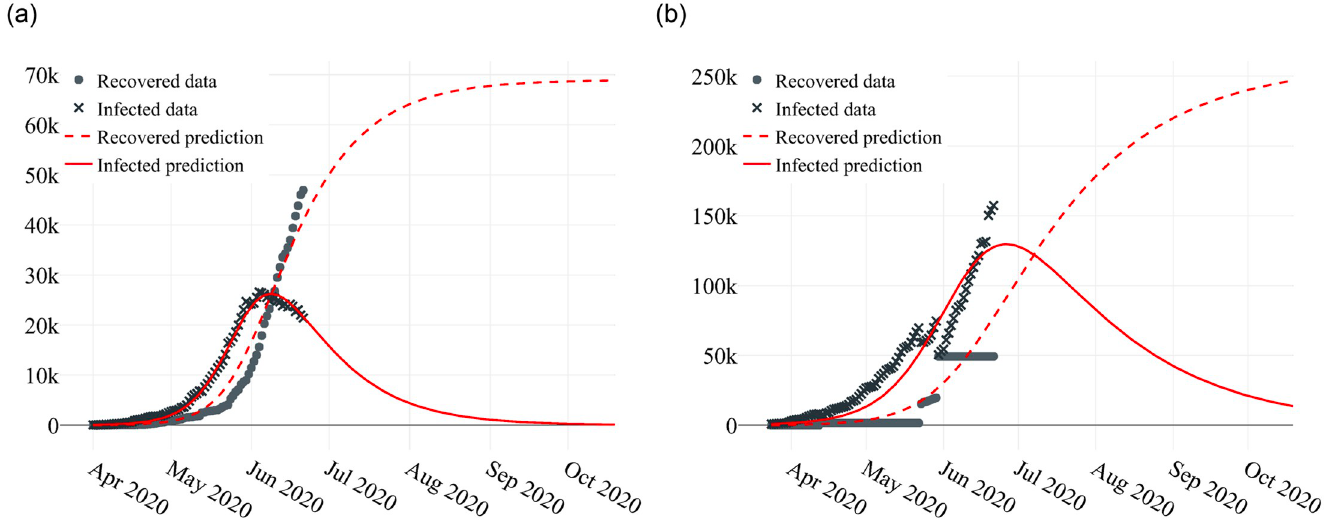
Fig 1. Comparison of predictions using the estimated models, with each state real data. (a) Maranh ã o results. (b) S ã o Paulo results.